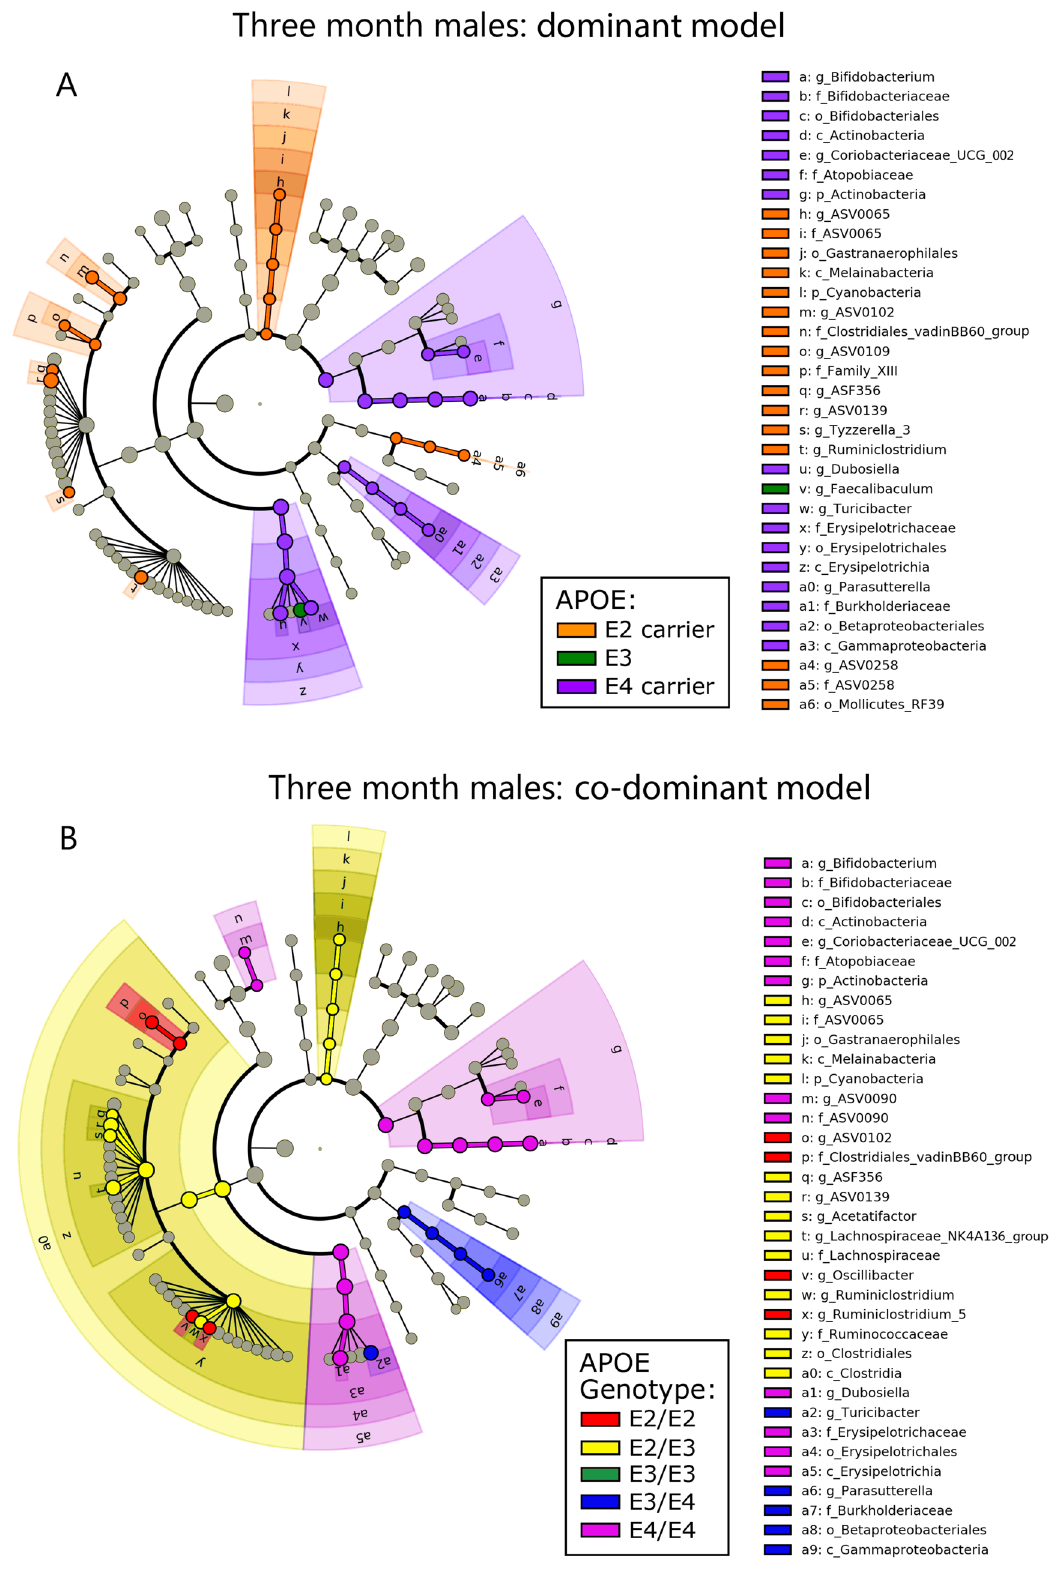
Figure 1. Cladograms reveal microbial phylogenetic branches associated with APOE status in males. Taxa are represented as nodes and are connected by lines based on the phylogenetic relatedness of all taxa present in each experimental cohort. For example, the end node, a. represents the genus Bifodobacterium which is connected to other nodes representing higher level taxa related to Bifodobacterium including; b. the family Bifidobacteriaceae, c. the order Bifidobacteriales, and d. the class Actinobacteria. Many taxa are associated with APOE genetics, with node colors indicating the APOE associated with highest levels of that taxa. Statistical significance reflects both p < 0.05 for Kruskal–Wallis tests and a logarithmic LDA score >